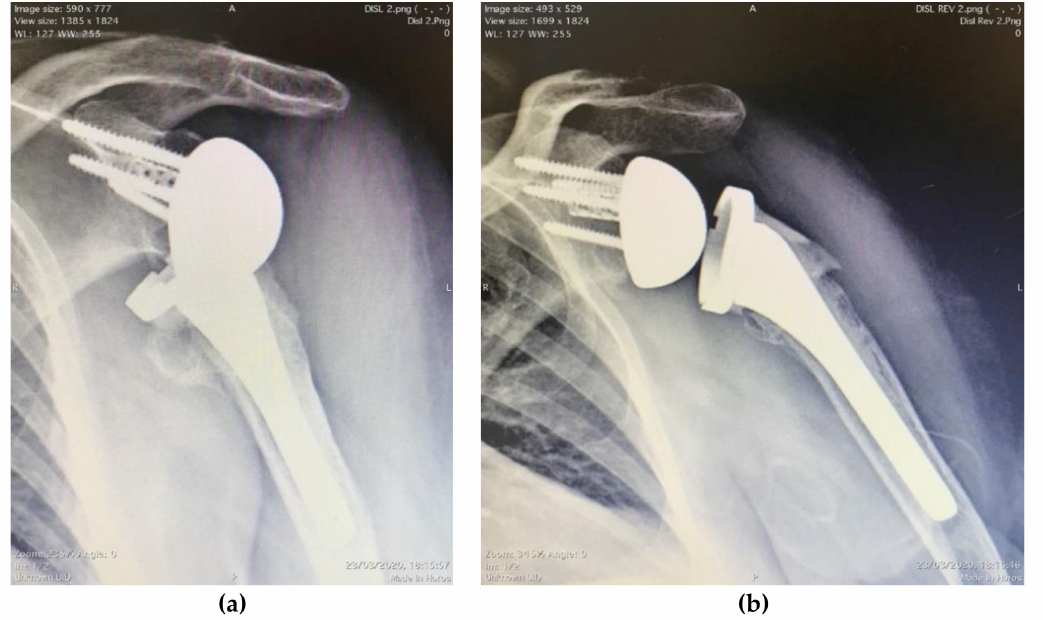
Figure 2. A case of dislocated arthroplasty ( a ), successfully treated through a revision of the implanted stem, replaced with a longer cemented one ( b